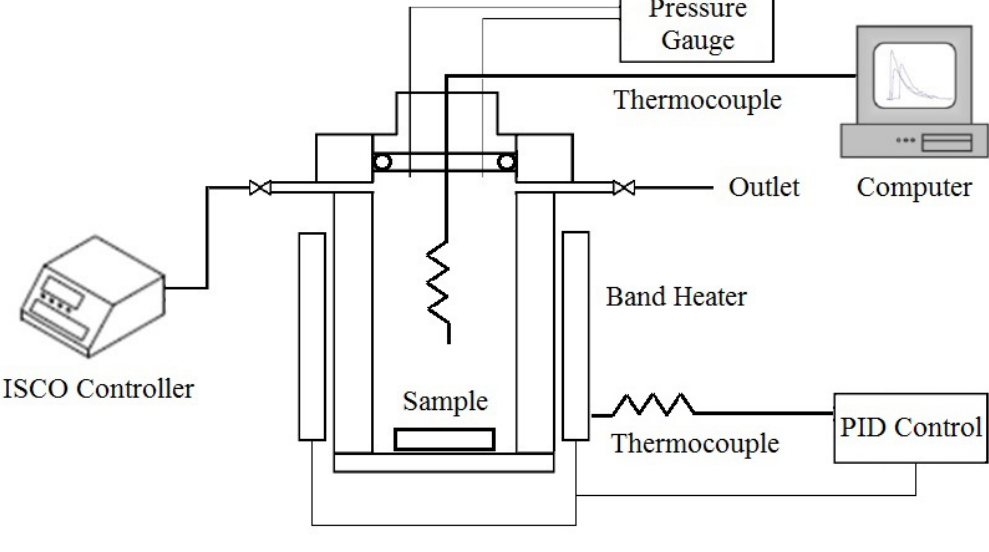
Figure 5. Schematic diagram of pressure vessel